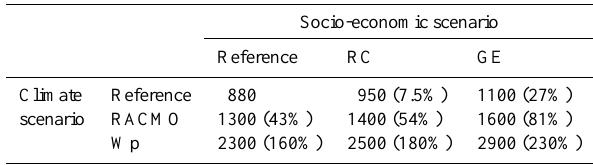
Table 6. Basin-wide annual expected damage (risk) in million C per year. The factor of change is displayed in brackets. The reference year is 2000 and the scenarios represent 2030.